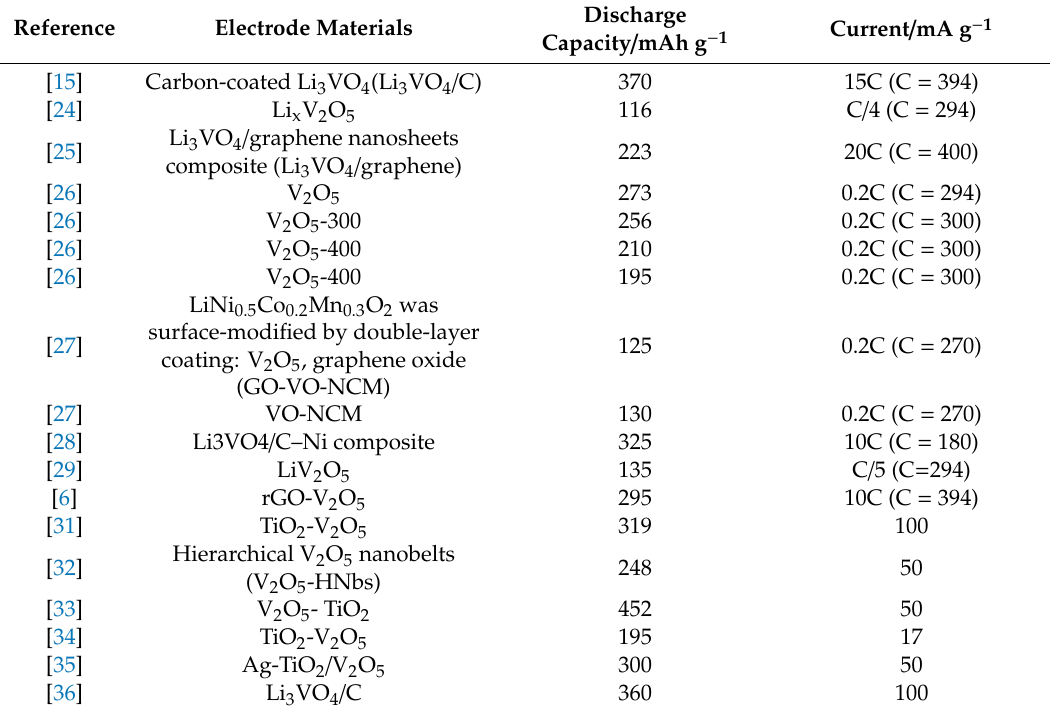
Table 2. Comparison of the type of materials (various VxOy) with preparation methods in the